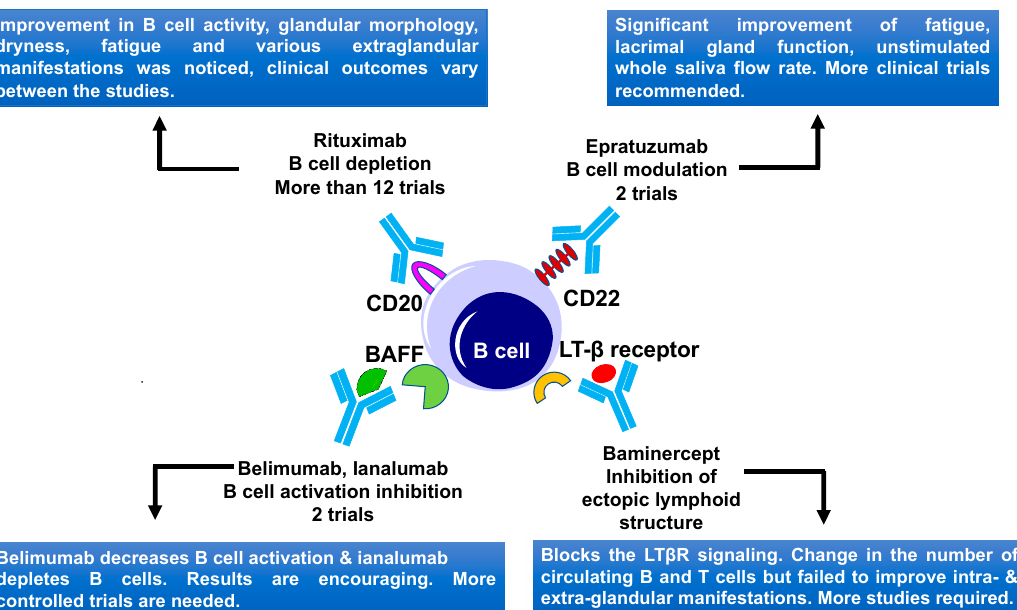
Figure 5. B cell-targeted therapies and their outcomes in primary Sjögren’s Syndrome. Current therapies include CD20, CD22, BAFF, and LT β receptor targeting. BAFF, B-cell activating factor; LT β , lymphotoxin β ; and LT β R, lymphotoxin β receptor.